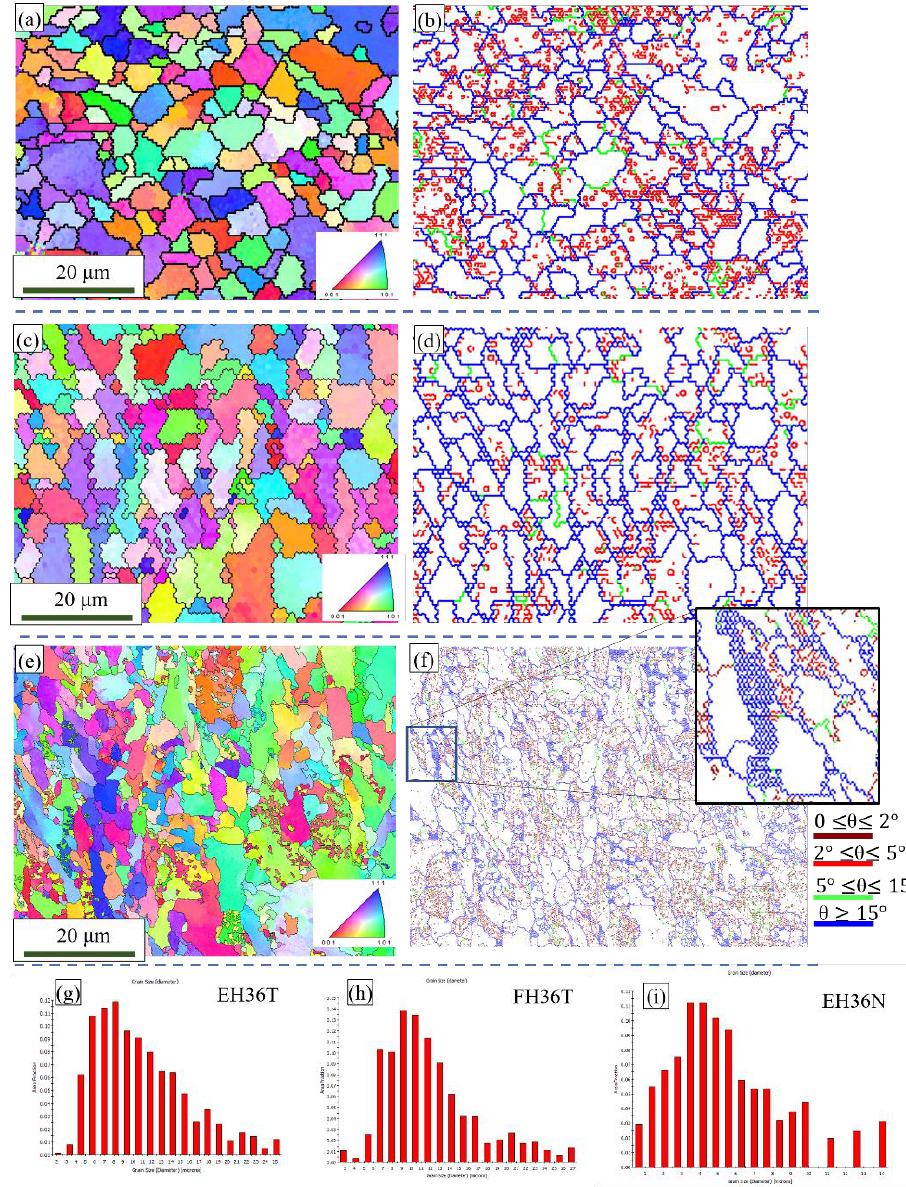
Figure 5. Orientation maps and distribution of grain boundaries: ( a , d ) EH36, ( b , e ) FH36T, ( c , f ) FH36N, and ( g – i ) histogram rams of frequency of grain boundaries of the offshore steels.